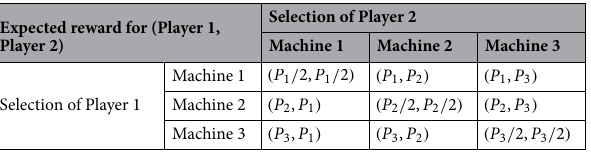
Table 1. Profit table of expected reward. Reward is splitted when the selection is in conflict between two Detail algorithm of greedy policy, equilibrium policy, and entanglement policy.